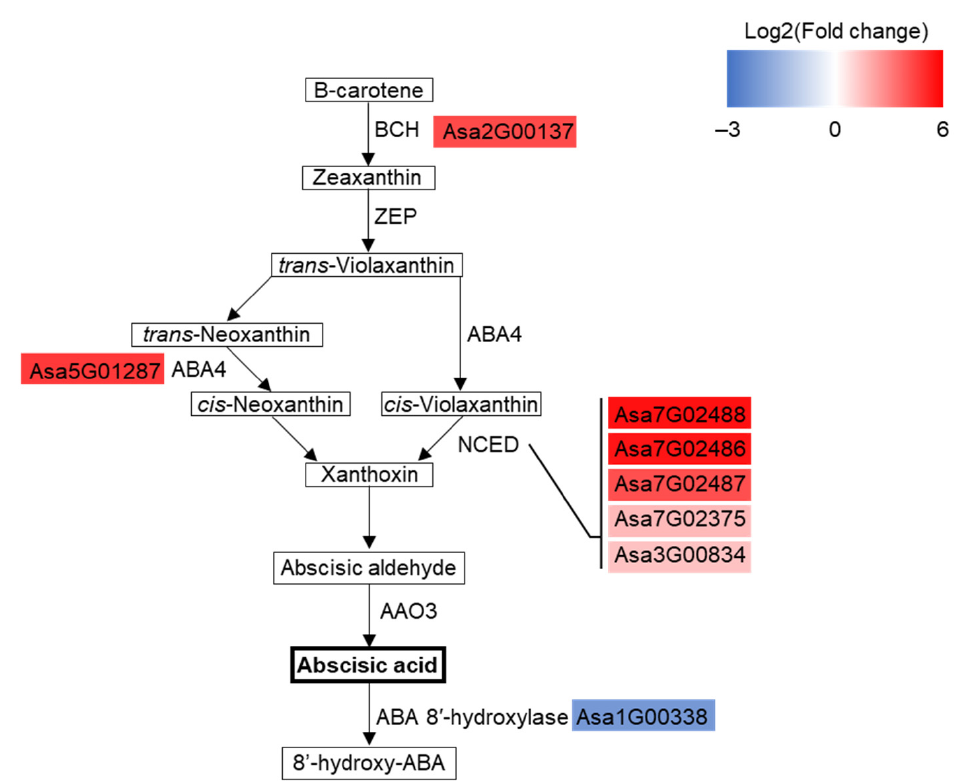
Figure 6. ABA biosynthetic and catabolic pathways in higher plants. BCH, beta-carotene hydroxylase; ZEP, zeaxanthin epoxidase; NCED, nine- cis -epoxycarotenoid dioxygenase; AAO3, aldehyde oxidase 3; ABA4, ABA deficient 4. The color scale indicates Log2 of fold change. The pathway was generated based on the Kyoto Encyclopedia of Genes and Genomes database.